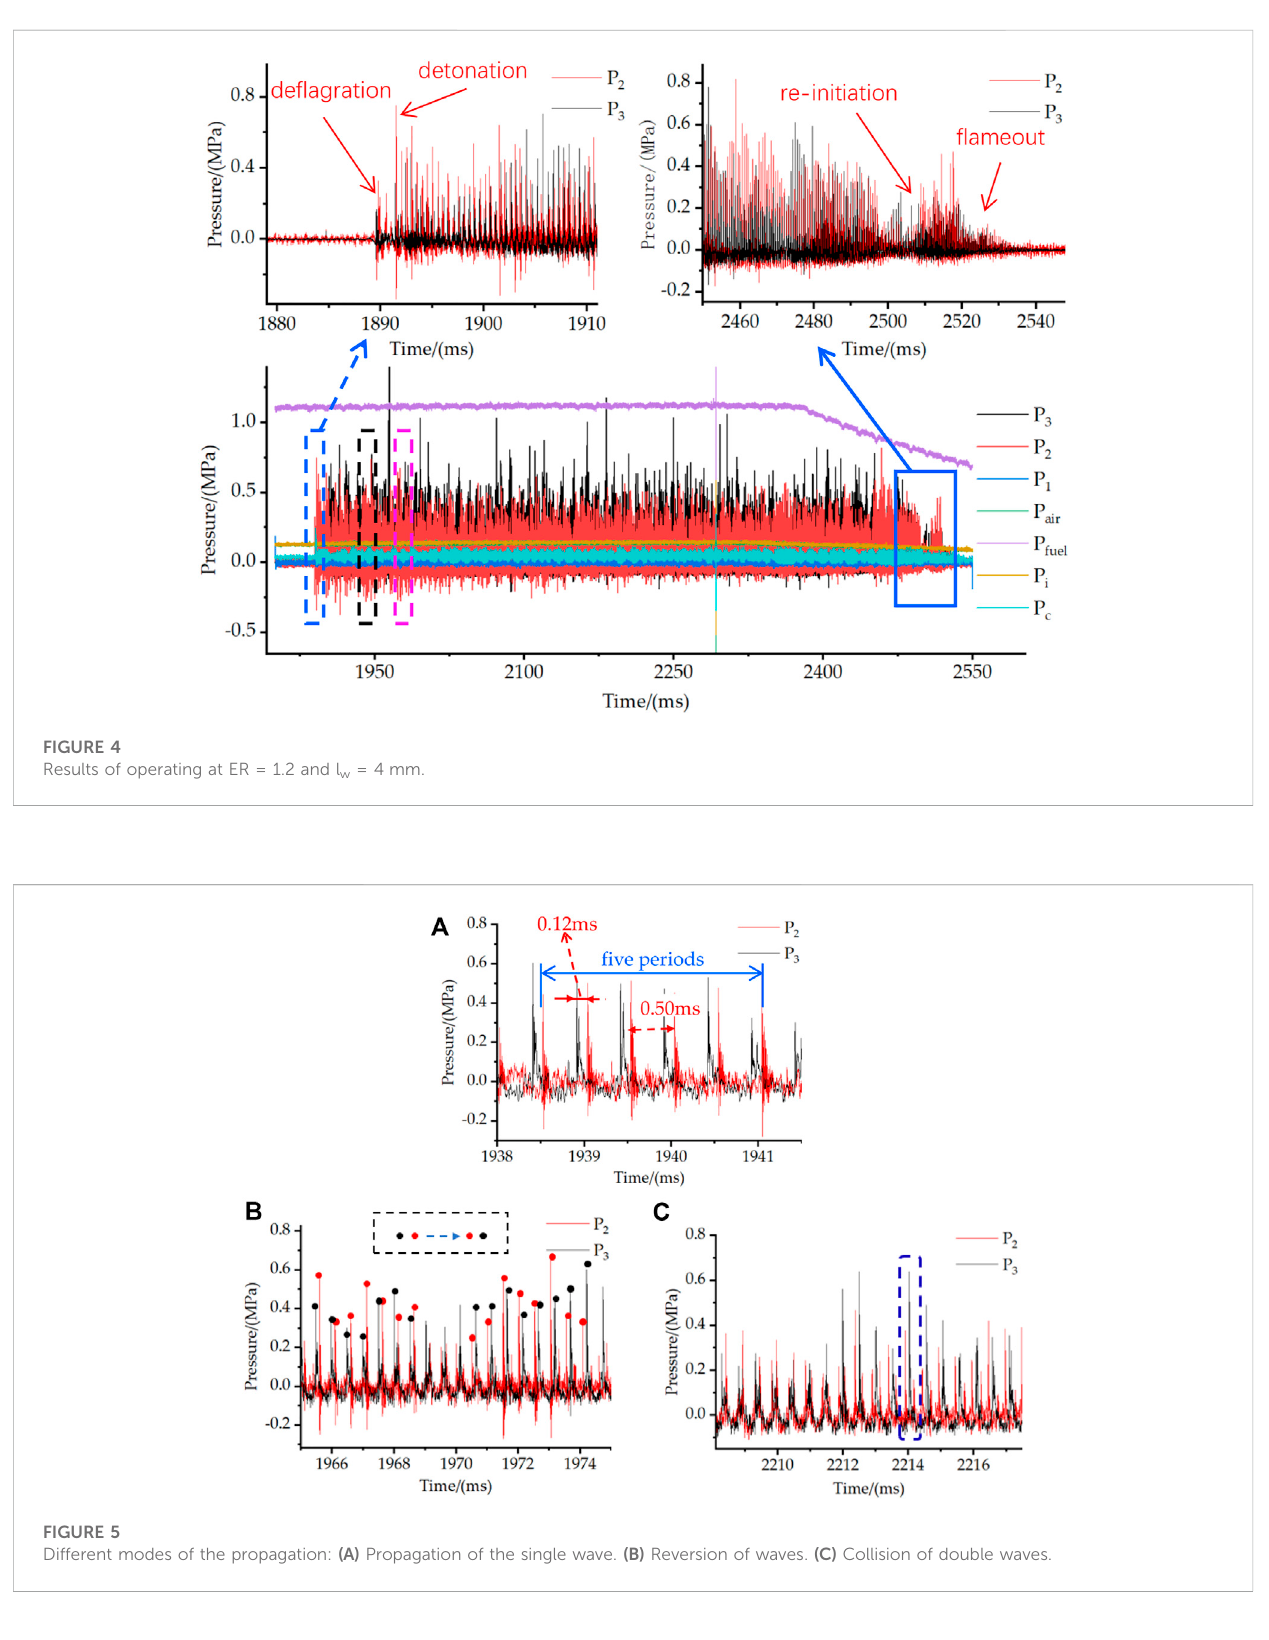
isolator was located 120 mm away from the isolator entrance and used to analyze the impact of detonation waves on the fl ow fi eld in the upstream isolator. Sensors P 2 and P 3 , installed in the combustor,